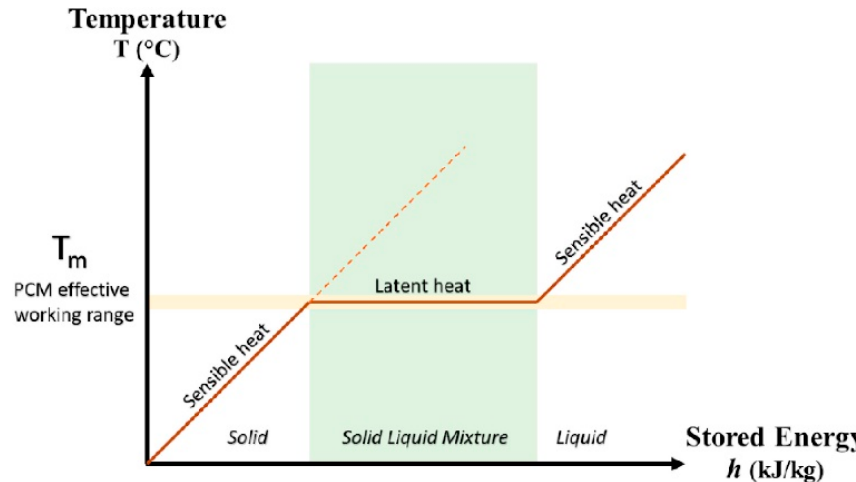
Figure 4. PCM energy storage by temperature variations [26].